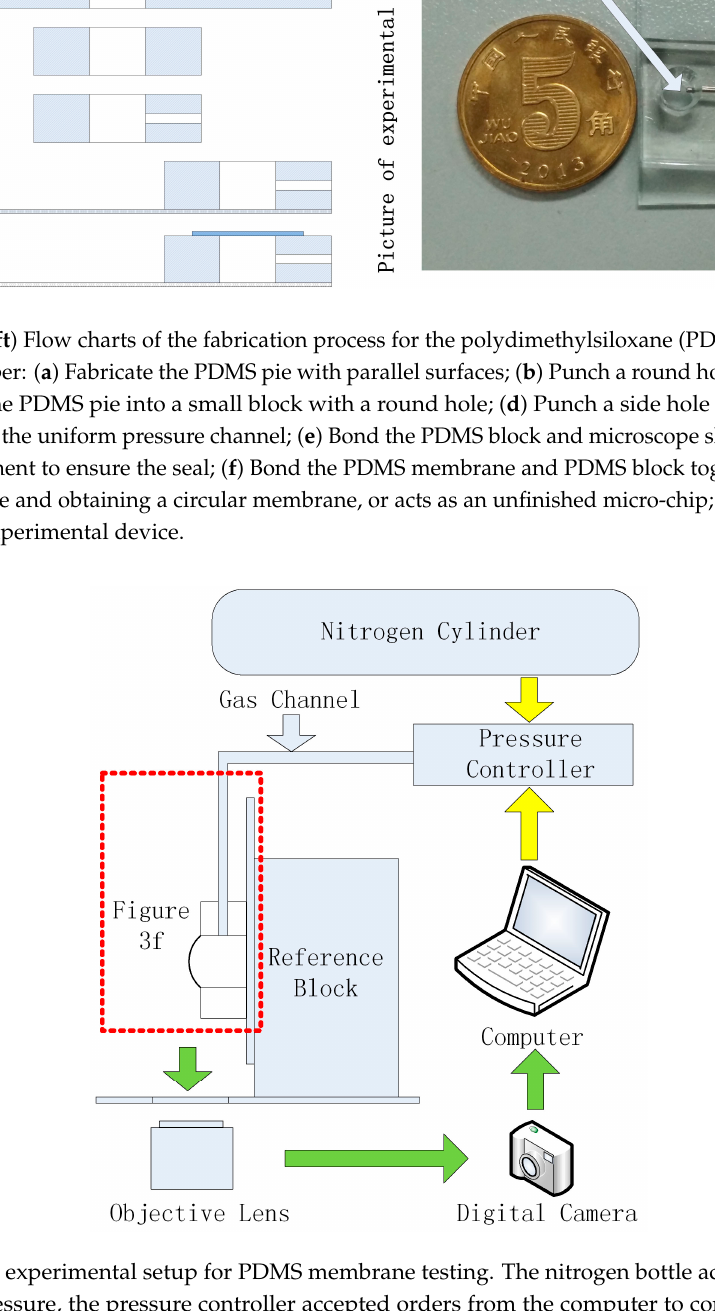
Figure 4. The experimental setup for PDMS membrane testing. The nitrogen bottle acted as a source of the gas pressure, the pressure controller accepted orders from the computer to control its output pressure and connected with the testing device in Figure 3 by gas channel, the testing device was fixed on the reference block to keep vertical to the stage, the digital camera captured the images of the deflected membrane through the objective lens.